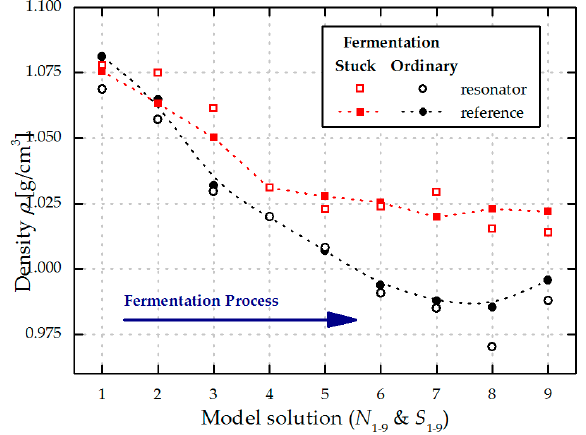
Figure 11. Density values for ordinary ( N 1–9 ) and stuck ( S 1–9 ) fermented model solutions evaluated with the piezoelectric MEMS resonator (unfilled dots) and its reference values obtained with a Stabinger SVM3000 viscometer (filled dots). The inserted dashed lines serve as guides for the eye.